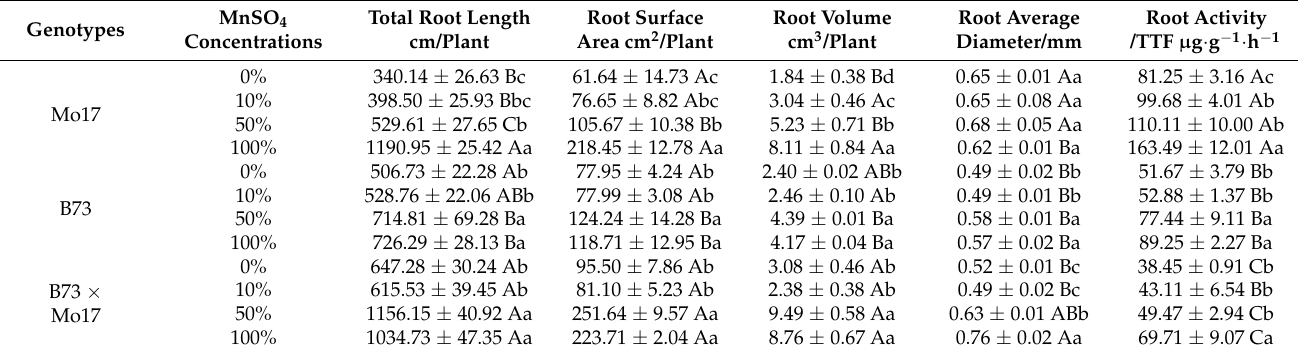
Table 4. Effect of Mn deficiency on root morphological phenotype and root activity of maize seedlings.